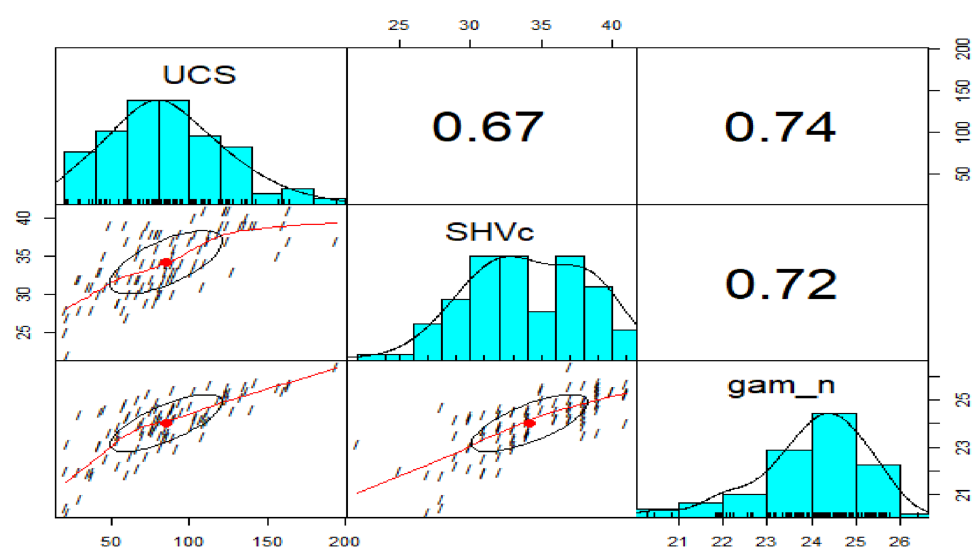
Figure 3. Pairwise scatterplots of the three